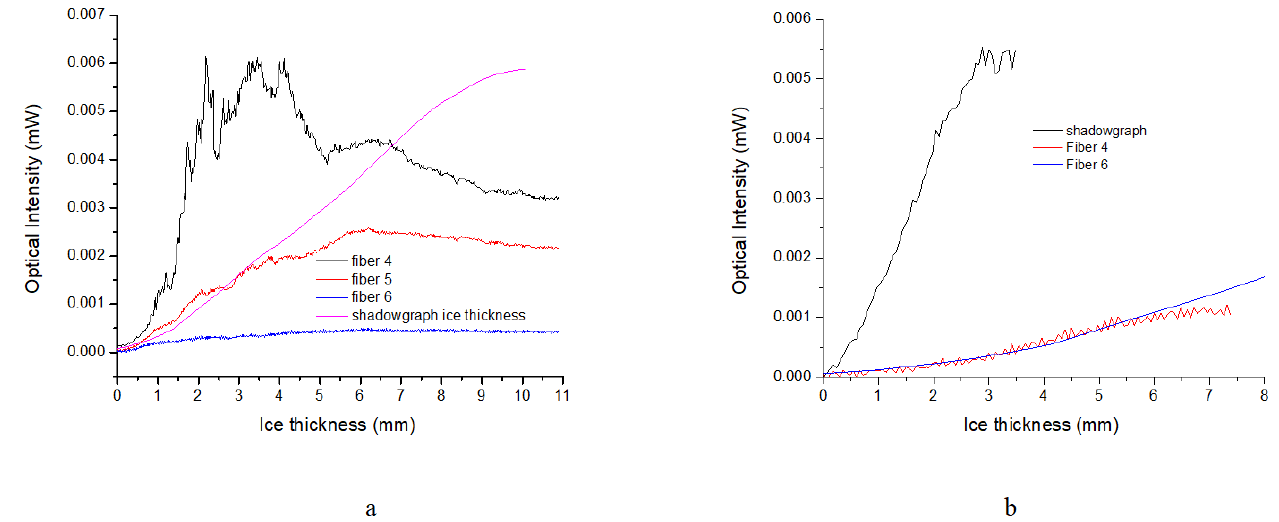
Figure 10. ( a ) Ice growth curves for fibers 4, 5, 6 together with shadowgraph tailored for fiber 5; ( b ) shadowgraph calibration curve for inner fiber 4 and outer fiber 6 with shadowgraph tailored for fiber 6.